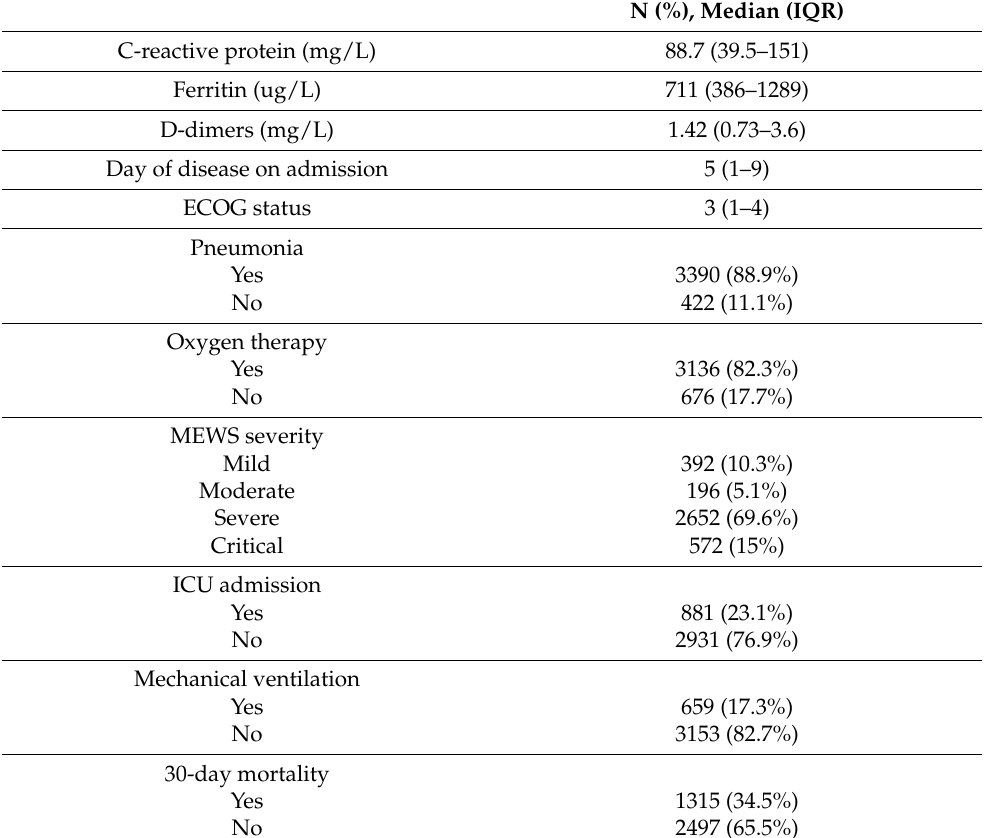
Table legend: AST—aspartate aminotransferase, ALT—alanine aminotransferase, GGT—gamma-glutamyl trans- ferase, ALP—alkaline phosphatase, IQR—interquartile range, ICU—intensive care unit, MEWS—modified early warning score, ECOG—Eastern Cooperative Oncology Group. * Prothrombin time values calculated for the patients not receiving oral